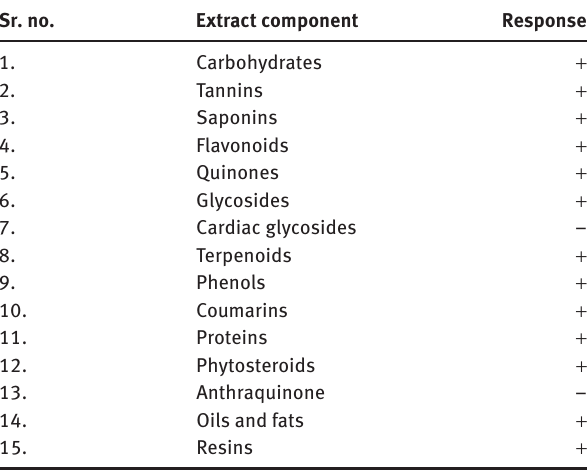
Table 1: Qualitative response of various components in Leucaena leucocephala seed extracts.